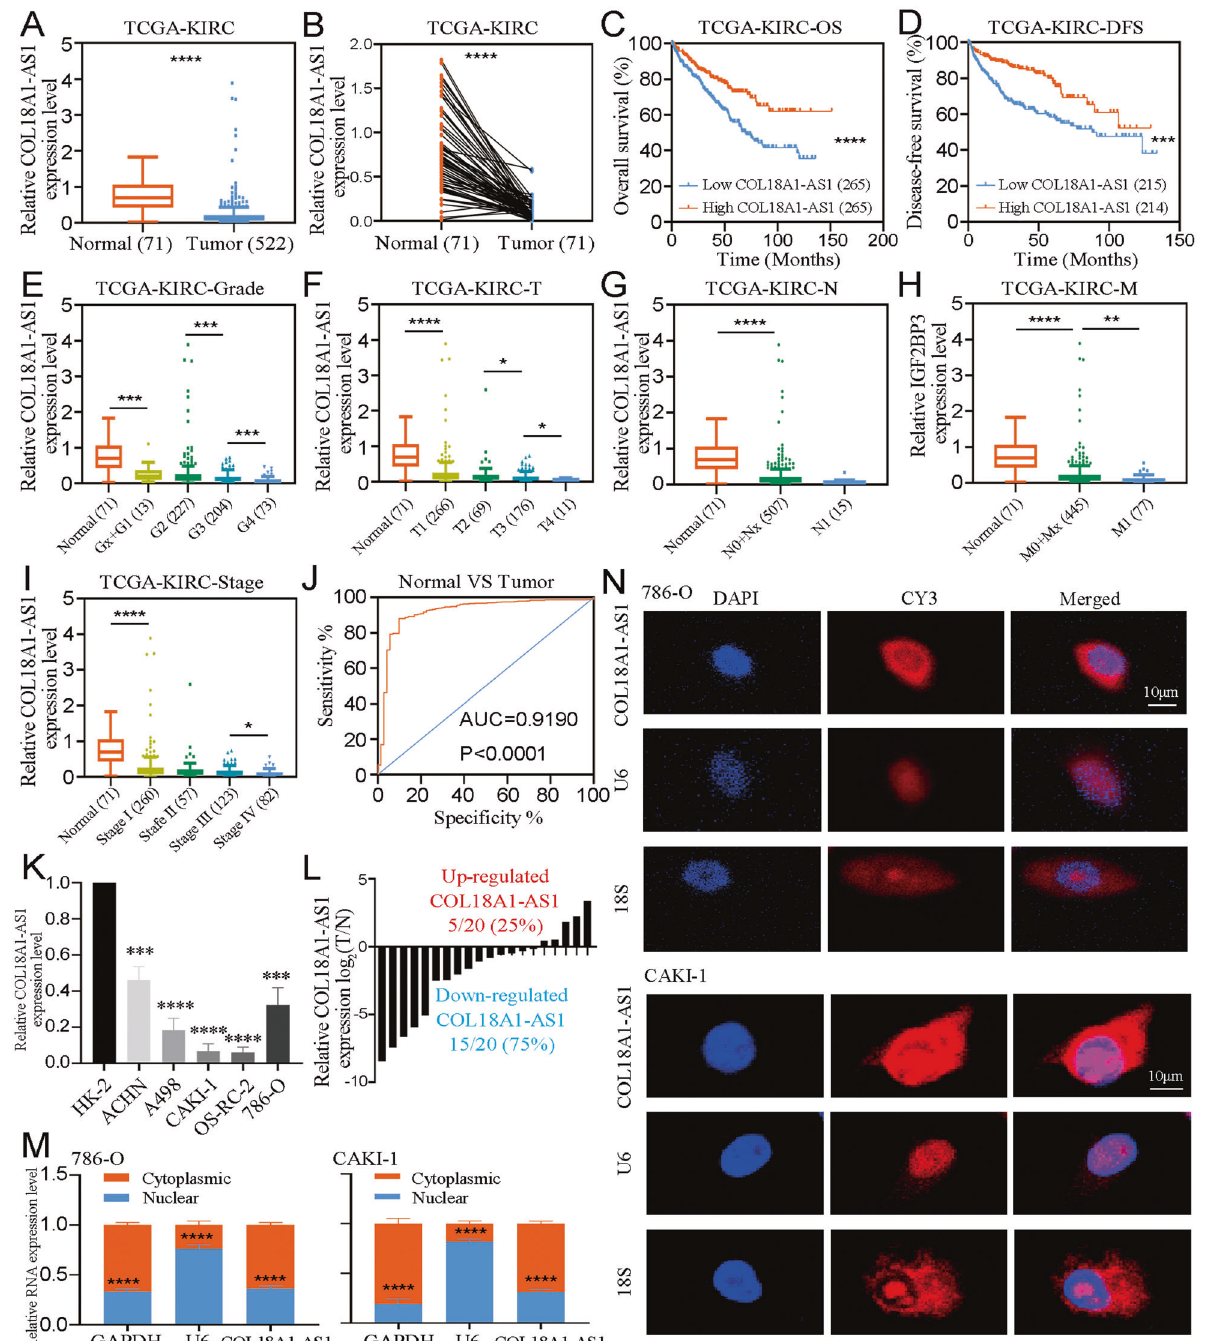
Fig. 1 COL18A1-AS1 was downregulated and could be a biomarker for ccRCC. A The expression level of COL18A1-AS1 in 72 normal renal tissues and 522 ccRCC tissues from TCGA database. B The expression level of COL18A1-AS1 in 71 pairs of matched ccRCC and normal tissues from TCGA database. C, D The Kaplan – Meier curves of COL18A1-AS1 in ccRCC for overall survival and disease-free survival. E – I The expression of COL18A1-AS1 was related with various clinicopathological factors. J The receiver operating characteristic (ROC) curves of COL18A1-AS1 (AUC = 0.9190; p < 0.0001). K The expression level of COL18A1-AS1 in RCC cell lines (ACHN, A498, CAKI-1, OS-RC-2, and 786-O) and normal cell line (HK-2). L The expression level of COL18A1-AS1 in 20 ccRCC tissues and adjacent normal tissues. M Localization of COL18A1-AS1 was assessed by PCR in CAKI-1 and 786-O cells. U6 and GAPDH were used as positive controls for nuclear RNA and cytoplasmic RNA, respectively. N The distribution of COL18A1-AS1 was analyzed by FISH in CAKI-1 and 786-O cells. 18 S and U6 showed cytoplasm and nucleus, respectively. Scale bars, 10 μ m. * P < 0.05, ** P < 0.01, *** P < 0.001, **** P < 0.0001. Error bars indicate mean ± SD. All the experiments were performed in